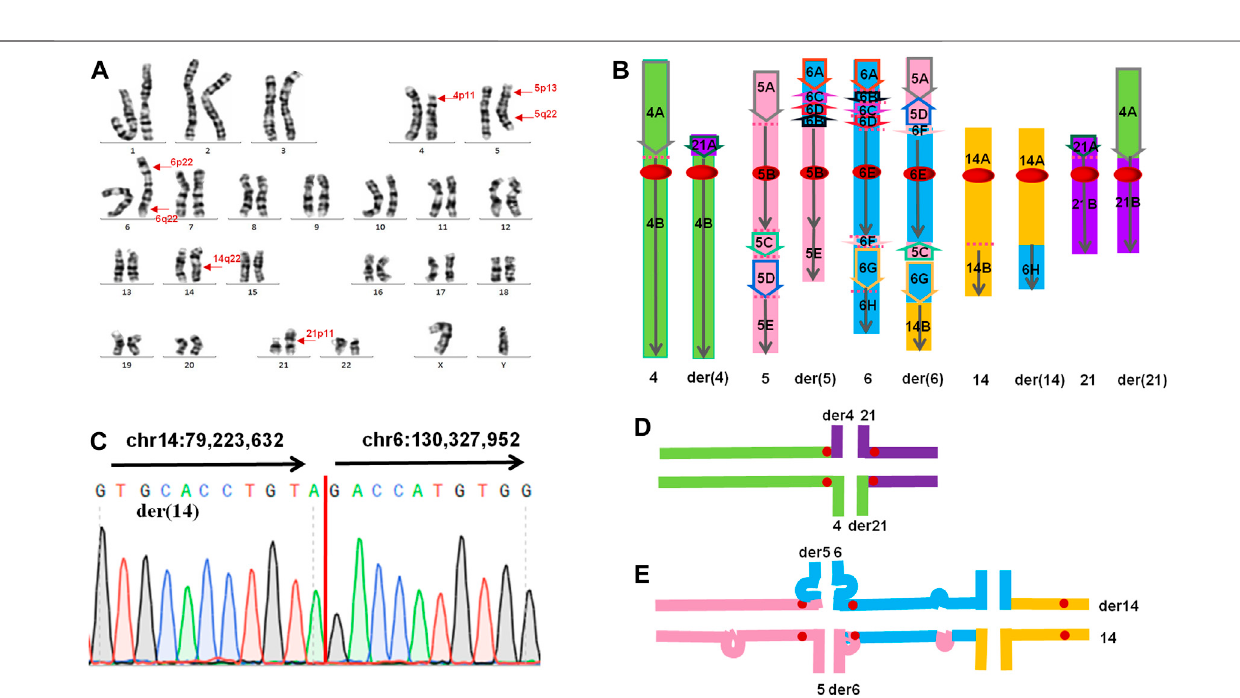
Frontiers in Genetics |